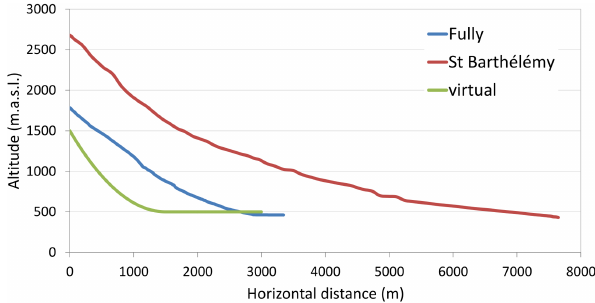
Fig. 13. Longitudinal profiles of the three case studies (see location in Fig.